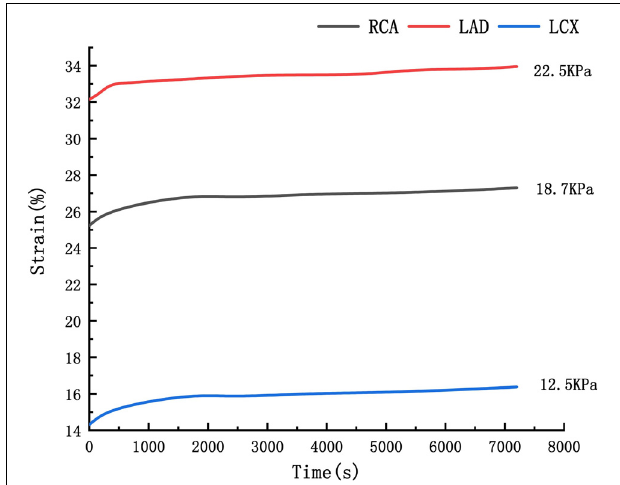
FIGURE 4 | Arterial strain-time curve.